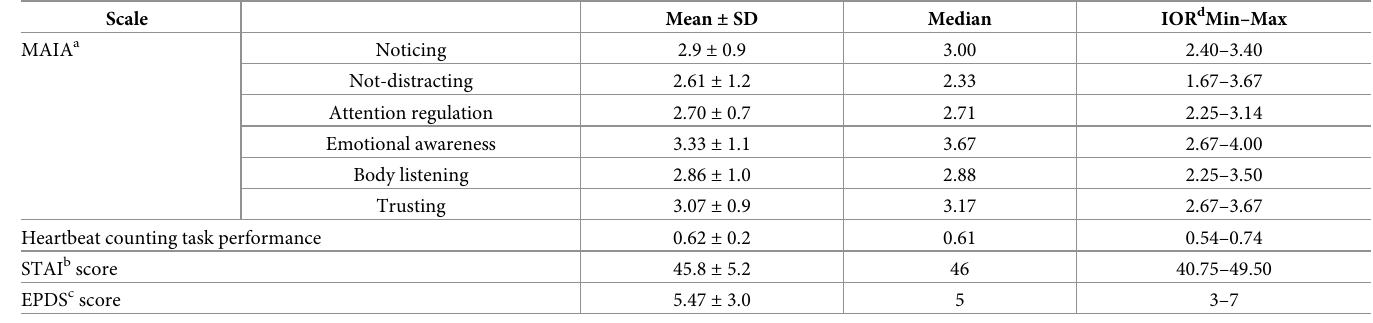
Table 2. Descriptive Statistics for each scale.